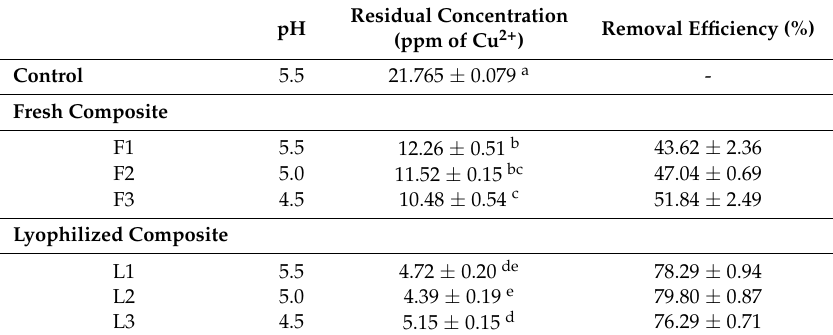
Table 1. Removal of copper using fresh composite beads and lyophilized composite beads at different pH values, at 35 ◦